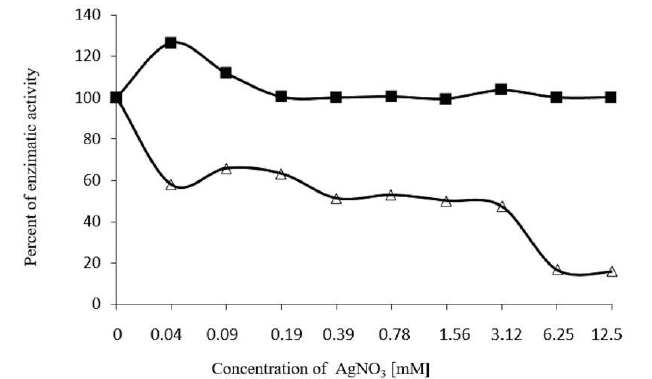
Figure 8. Effect of 2-mercaptoethanol on β -glucosidase, using different concentraions of AgNO 3 (0.04 a 12.5 mM ∆─∆ ) as inhibitors (35 °C, 30 min), enzymatic activity was determined using p -nitrophenyl- β -glycopyranoside, and after incubating with 50 µL of 2-ME 100 mM ■─■ under the same conditions. Enzymatic activity was recorded at 410 nm.